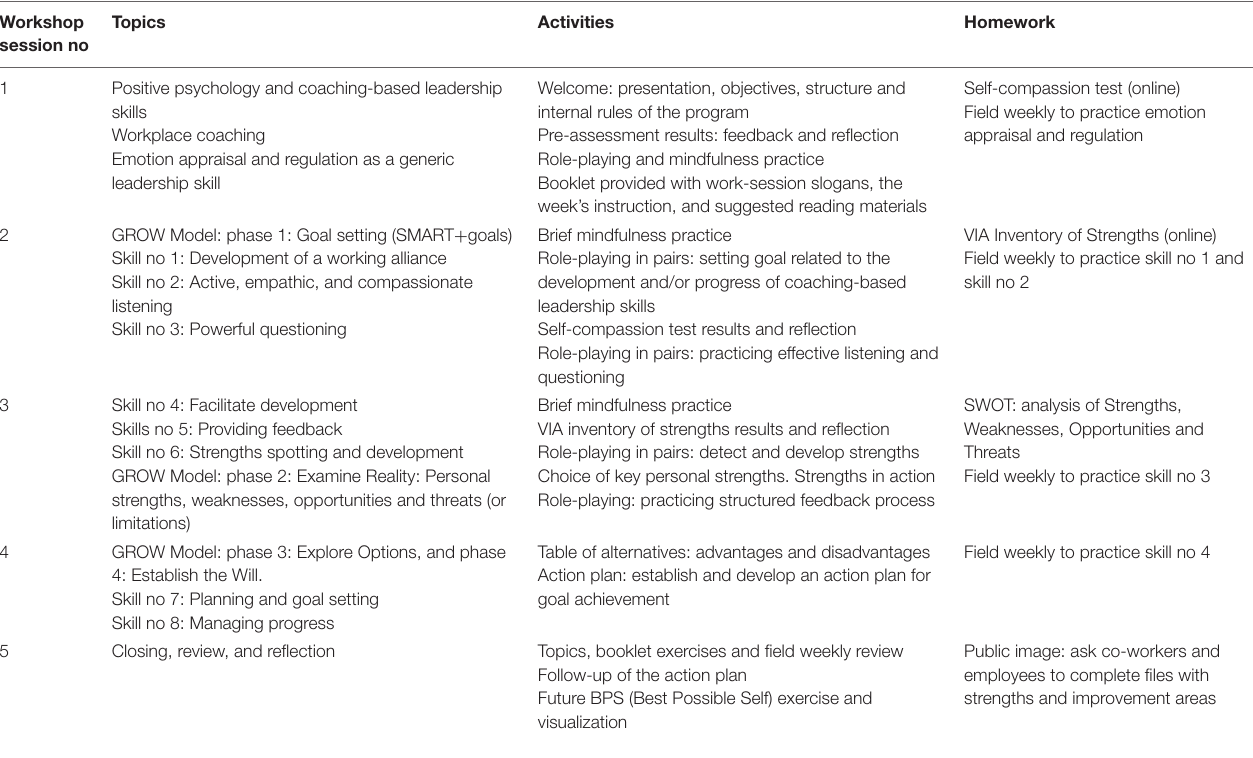
TABLE 1 | Specific workshop session contents.